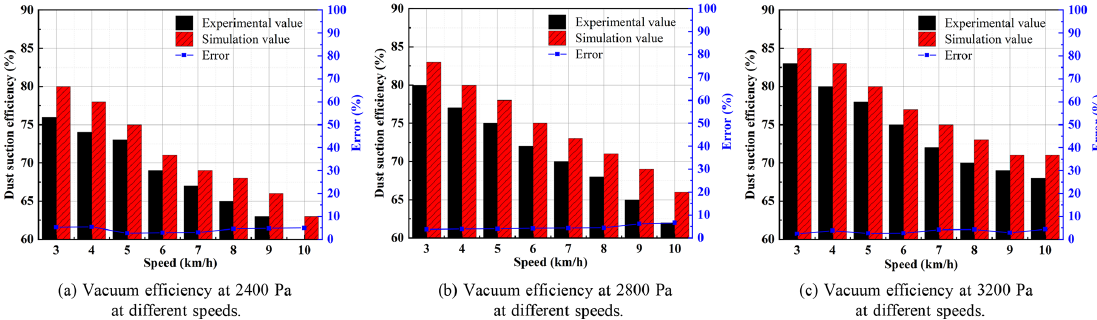
Figure 11. Comparison of simulated and experimental dust extraction efficiency at different driving speeds and negative pressures.